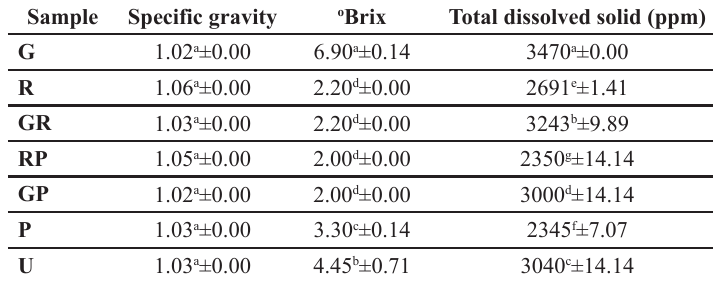
Table 2: Specific gravity, Brix and total dissolved solids of yoghurt from pre-treated Bambara groundnut.